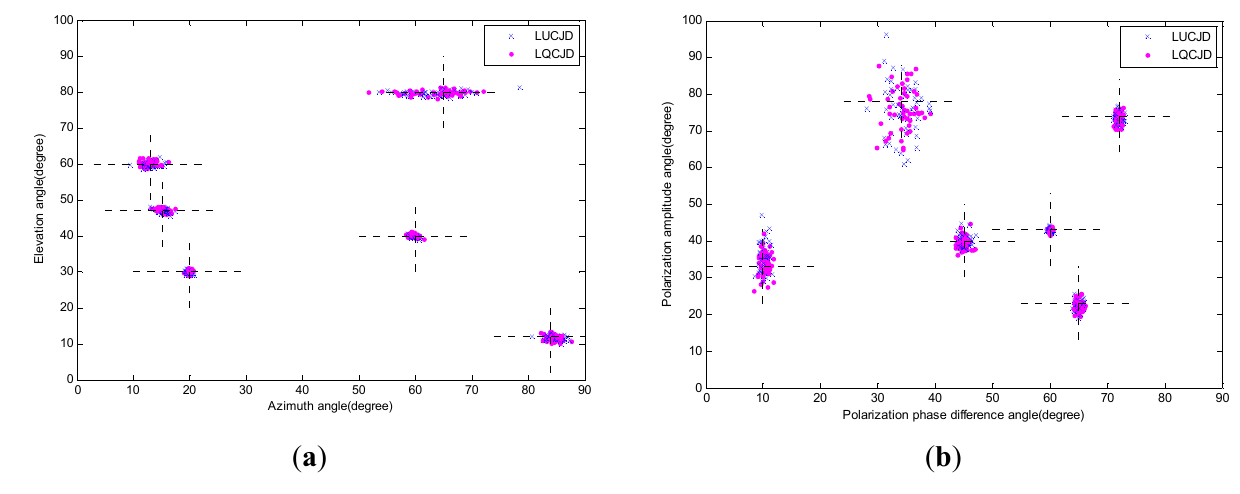
Figure 3. The distribution of DOA and polarization estimates from 50 independent runs, SNR is 30dB, the number of snapshots is 1,000. The noise is with covariance levels ( ρ = (0.5, 0.5). ( a ) Distribution of DOA estimates. ( b ) Distribution of polarization